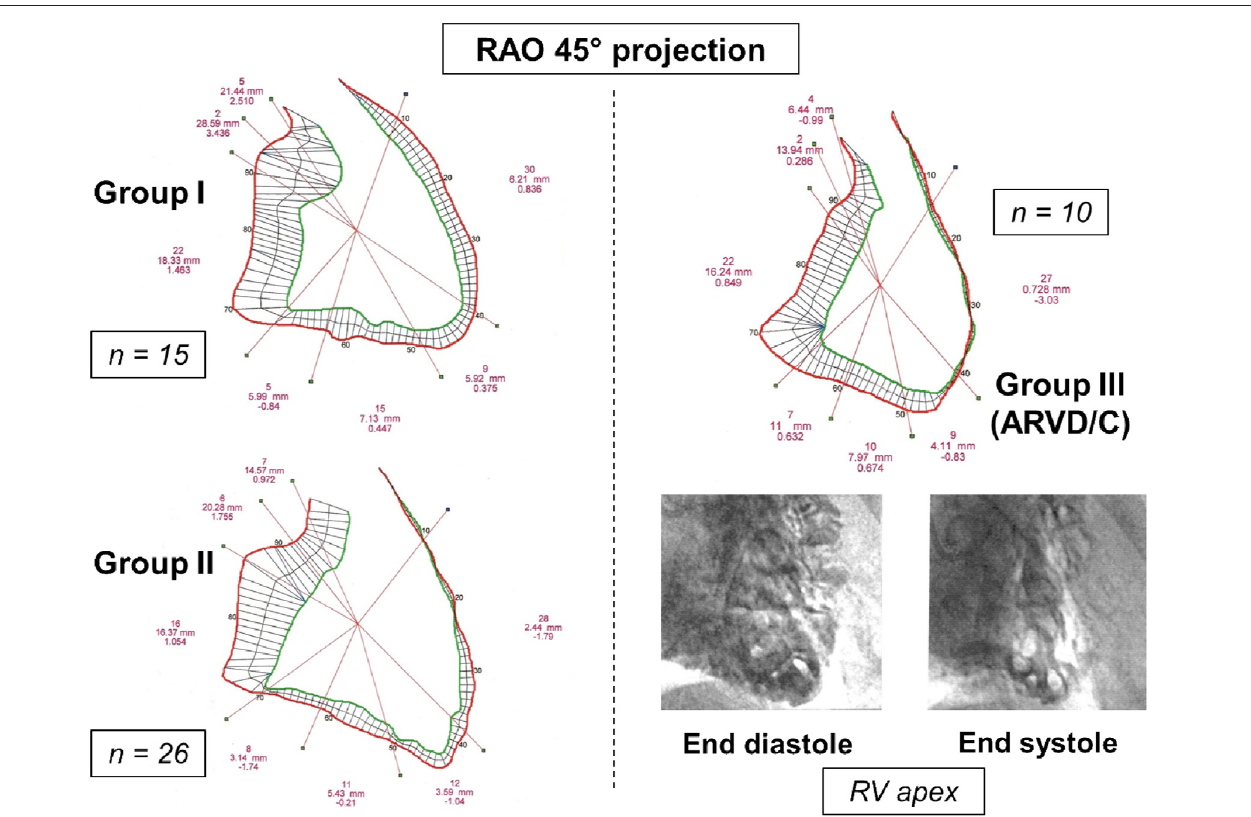
hypokinesia, normal TAPSE, and crista supraventricularis shortening); and BrS group III: patients with BrS-ECG and angiographic abnormalities compatible with ARVD/C (patient 42: anteroapical akinesia, trabecular disarray and hypertrophy, end systolic polycyclic images). For each contour, the segmental excursions between diastole and systole are expressed in purple characters (from top to bottom: number of analyzed chords for each segment; mean segmental excursion in mm; standard deviation from